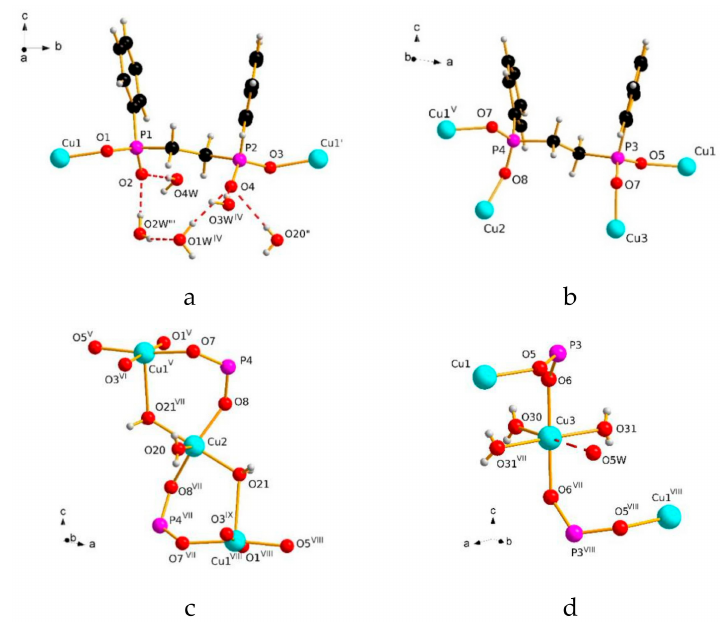
Figure 1. ( a ) Coordination mode of the first pc 2 p ligand; ( b ) Coordination mode of the second pc2p ligand; ( c ) Coordination of Cu1 and Cu2; ( d ) Coordination of Cu3. Color code: Cu turquoise, P purple, O red, C grey, H white. Symmetry transformations used to generate equivalent atoms: I = x, 1 + y, z; II = 1 + x, 1 + y, z; III = 1 − x, y, 1 ⁄ 2 − z; IV = 1 + x; y, z; V = x − 1, y, z; VI = x − 1, y − 1, z; VII = − x, y, 1 ⁄ 2 − z; VIII = 1 − x, y − 1, 1 ⁄ 2 − z.